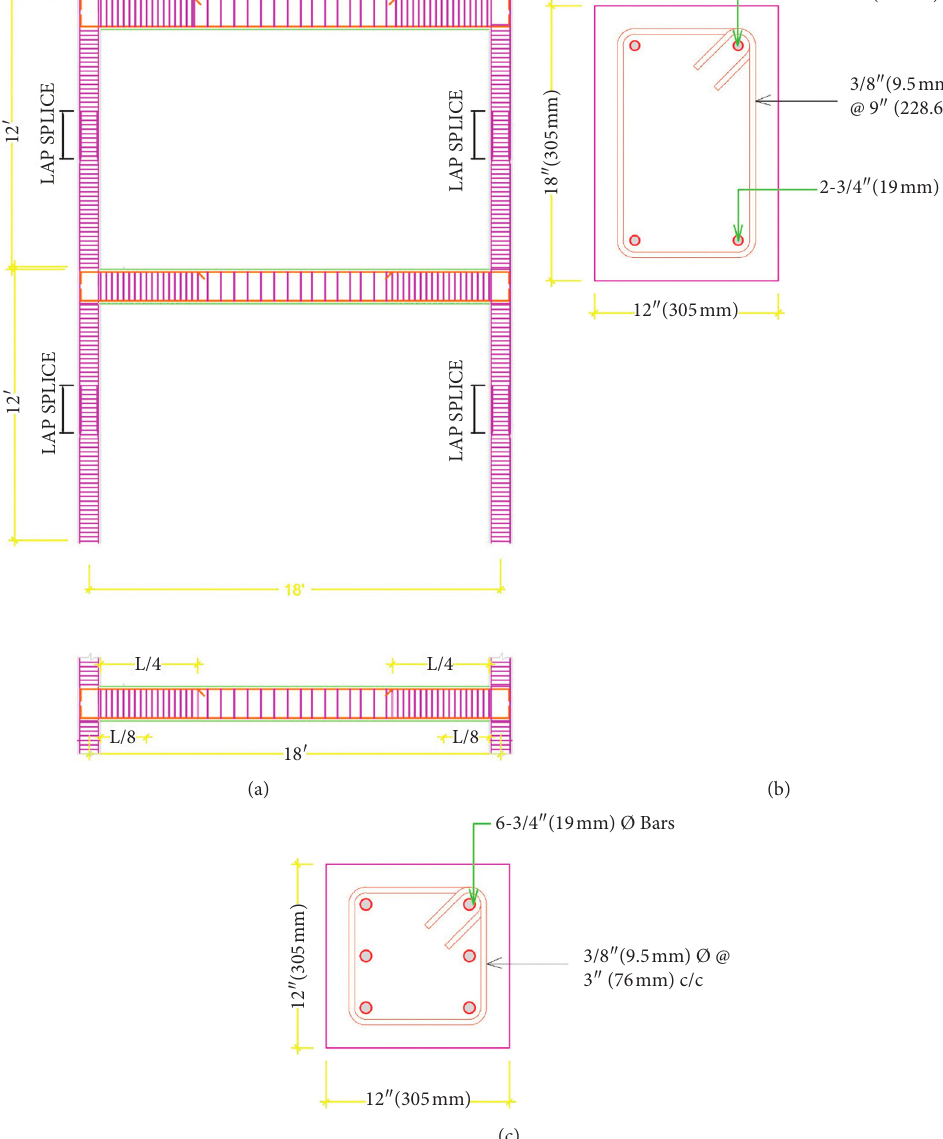
Figure 1: Geometric and reinforcement details of the considered RC SMRF structure. (a) Beam long section. (b) Beam cross section. (c) Column cross